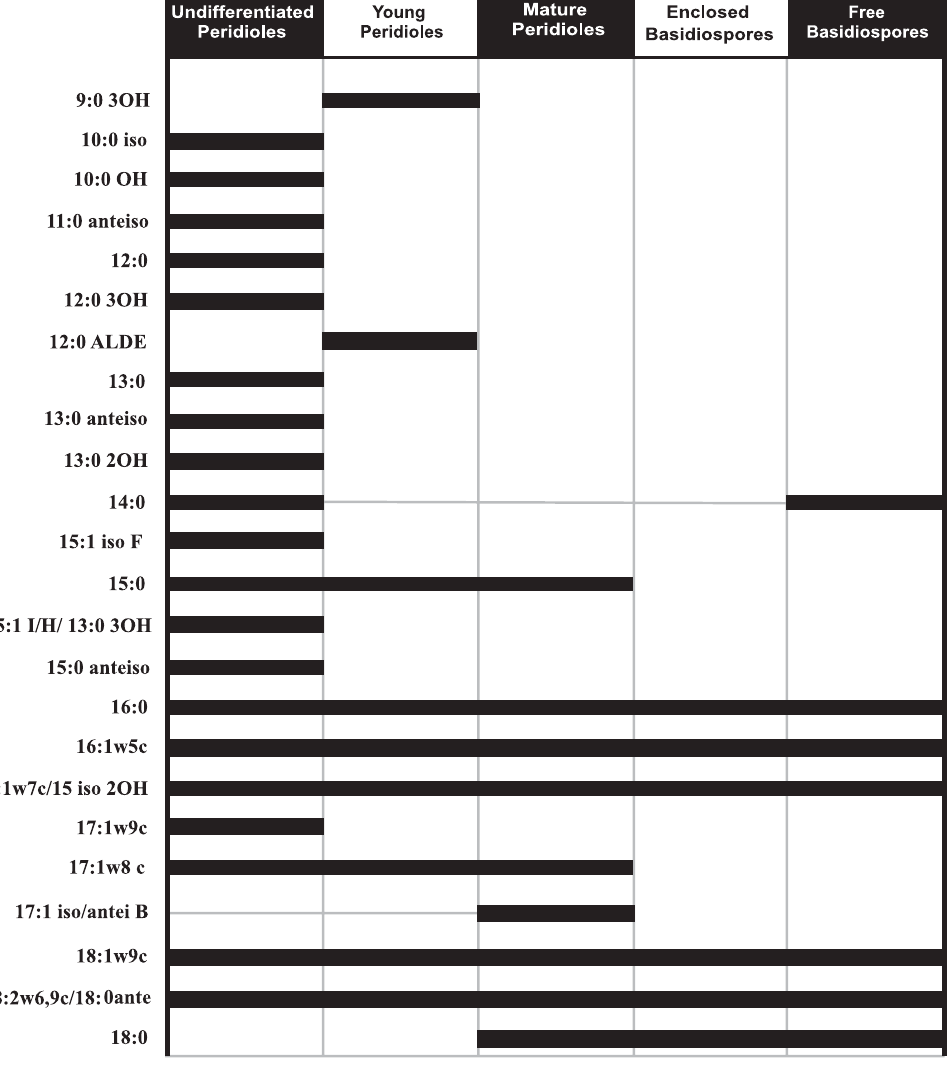
Figure 2. Distribution of fatty acids during the development of the peridioles that constitute the basidiocarps of Pisolithus